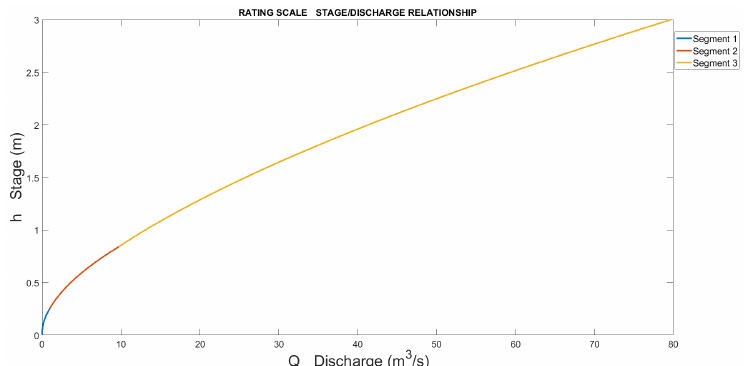
Figure 13. Rating scale of Pontelatrave with the 3 segments.